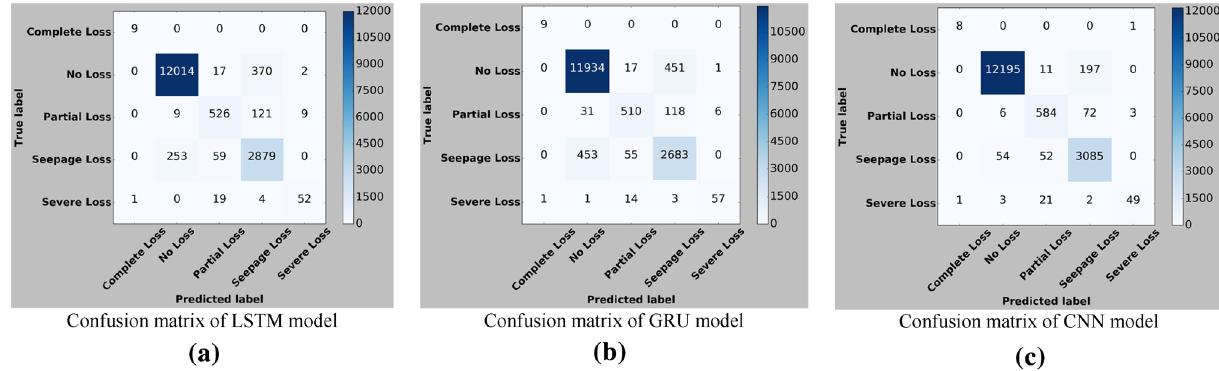
Fig. 12 Confusion matrices for: a LSTM, b GRU, c CNN models